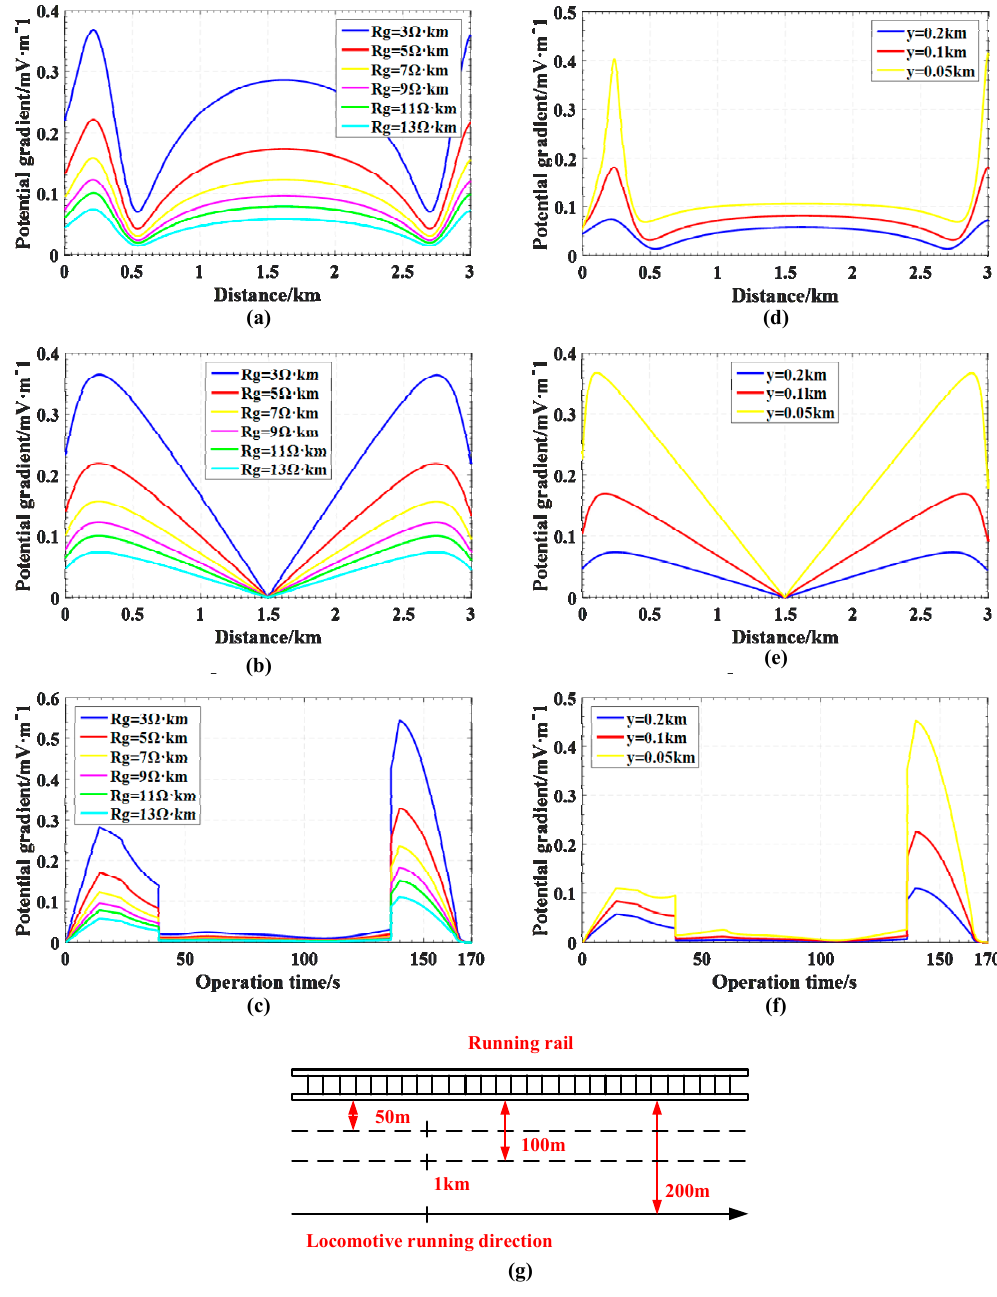
Figure 12. Sensitivity analysis considering operation modes: ( a ) Acceleration mode; ( b ) Deceleration mode; ( c ) Entire operation time; ( d ) Acceleration mode (25 s); ( e ) Deceleration mode (160 s); ( f ) Entire operation time; ( g ) Position instructions.